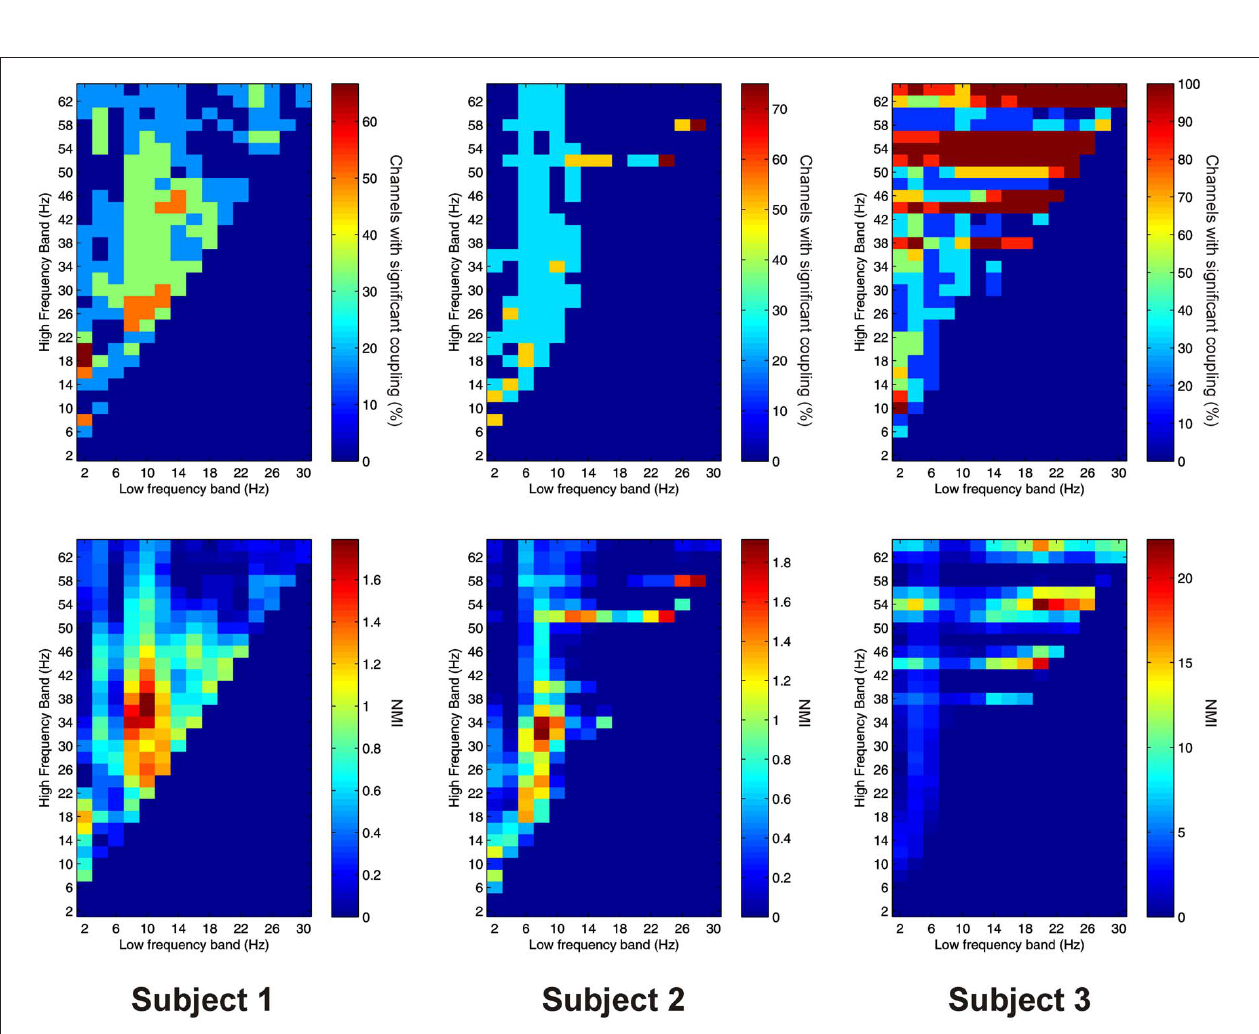
Frontiers in Human Neuroscience